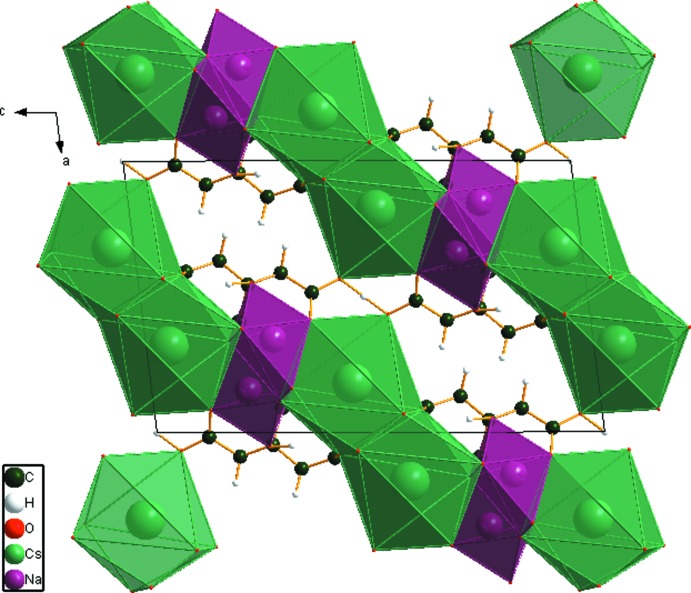
Crystal structure of NaCsHC6H5O7, viewed down the b axis.